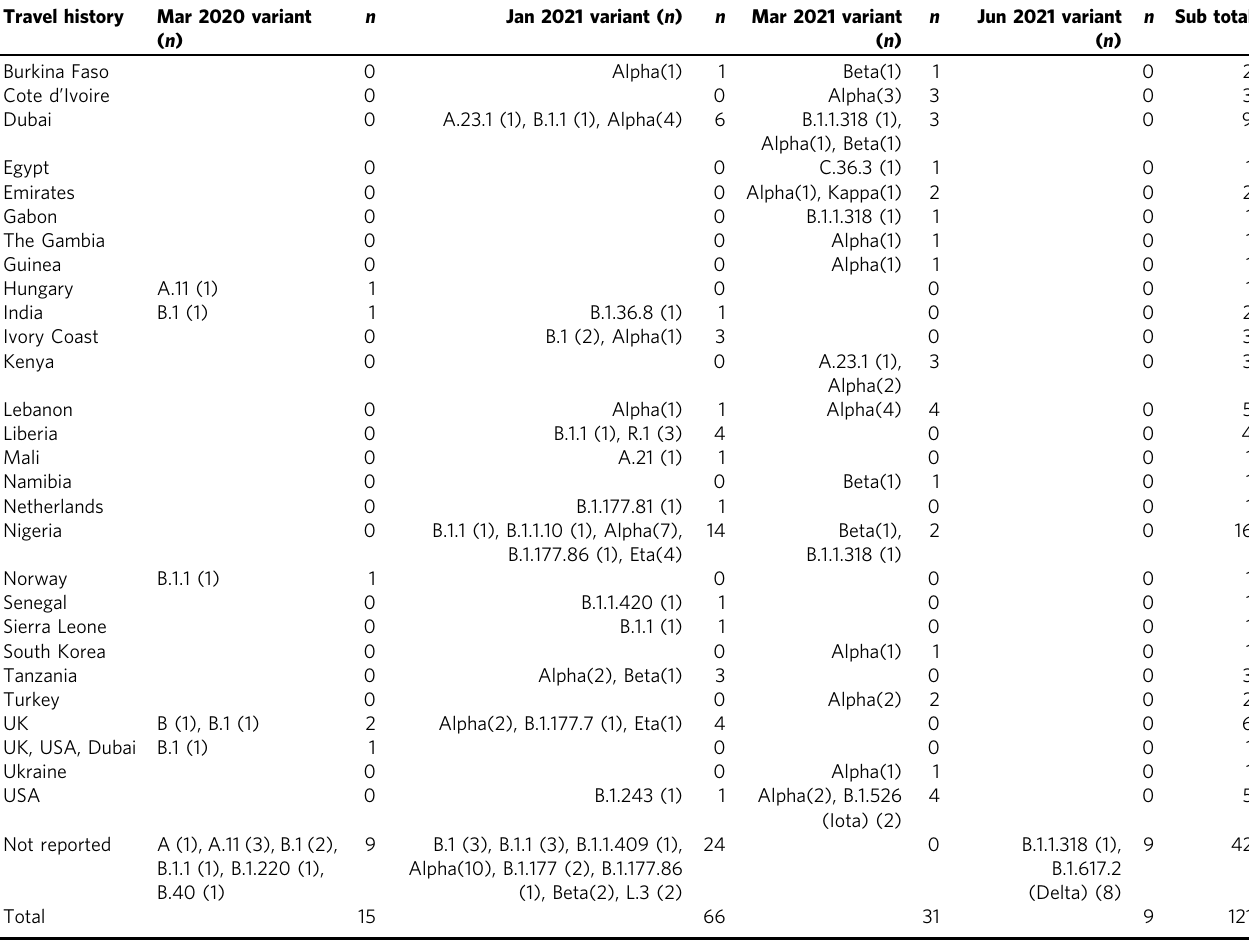
Table 1 Transmission of SARS-CoV-2 variants into Ghana from other countries ( n =